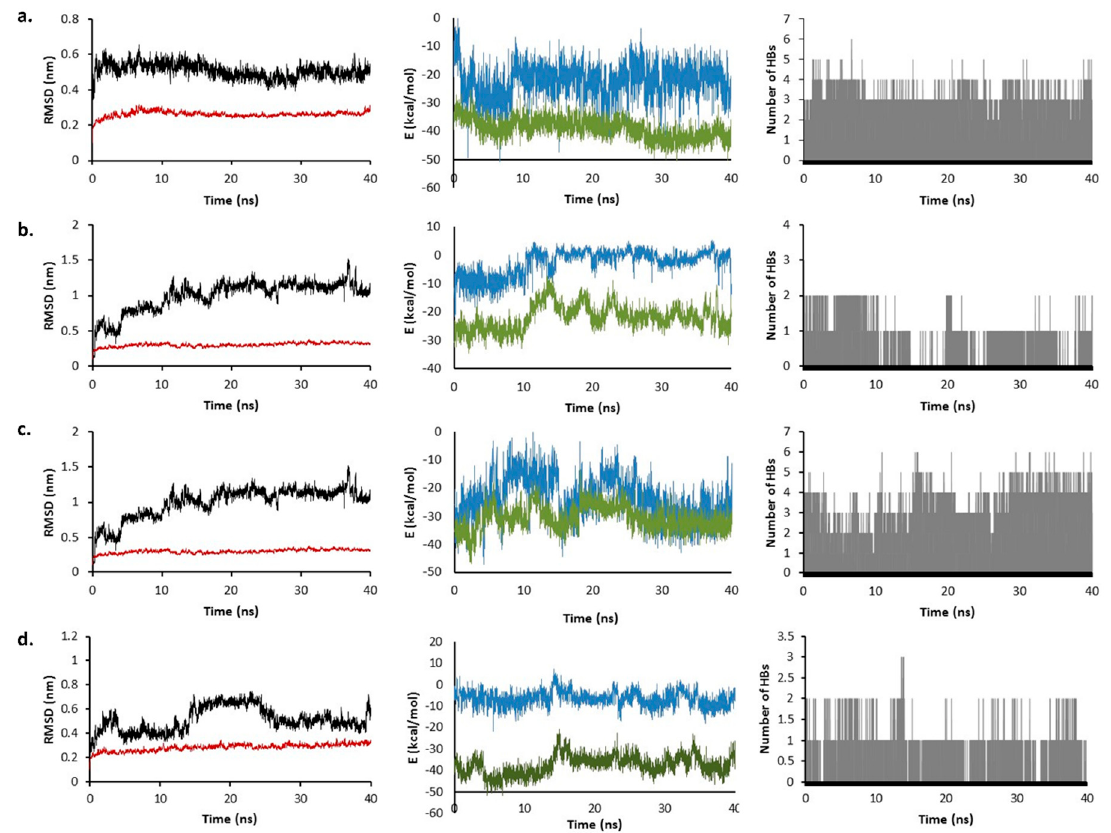
Figure 10. MD results for digoxin ( a ), chloroquine ( b ), remdesivir ( c ), and dronedarone ( d ) with RdRp. RMSD of the ligand is shown in black and of the protein-ligand complex in red. Coulomb interaction energy is presented in blue and Lennard-Jones in green.